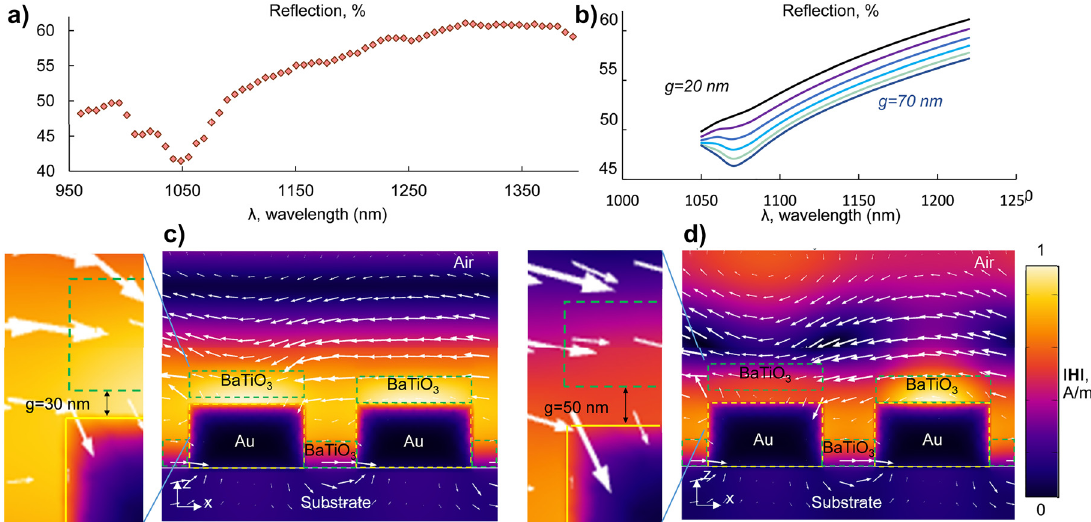
Figure 3: Impact of the nanomechanical motion on the optical properties of the ferroelectric-plasmonic nanostructure. (a and b) Experimental and simulated reflection spectra of the plasmonic-ferroelectric nanostructure. (b) Simulated spectra for various nanogap size ( g ) from 20 nm up to 70 nm in steps of 10 nm, as annotated. (c and d) The | H | -field distribution in the x - z plane, overlaid with arrows denoting the direction of the electric field, for one pair of gold nanowires and BaTiO nanobeam forms a 30 nm nanogap ( g ) with the gold nanowire, in (d) the nanogap is increased to 50 nm. In both color maps, input light is considered as plane wave with the polarisation vector along x -direction.